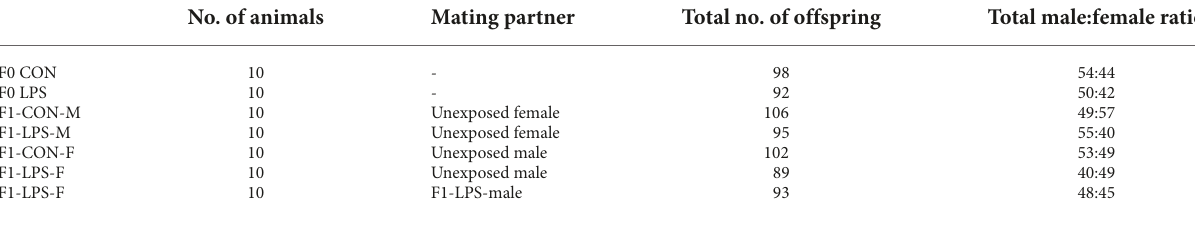
TABLE 1 Animal data in the